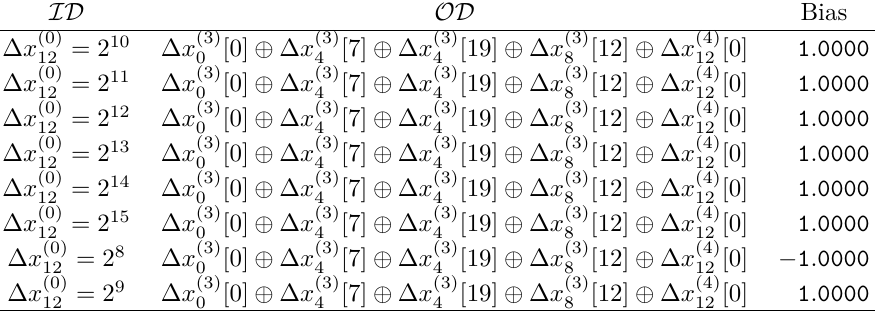
Table 9: Best multi-bit differentials for 3 rounds of